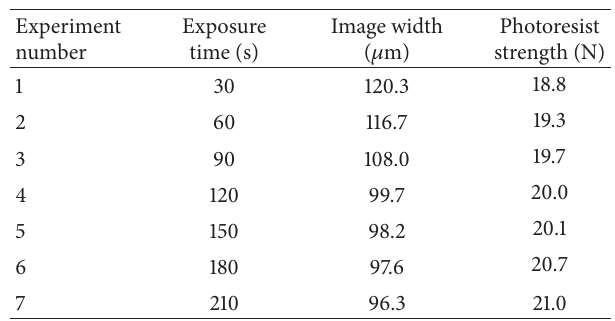
Table 2: Channel width and strength of photoresist obtained by different exposure times.